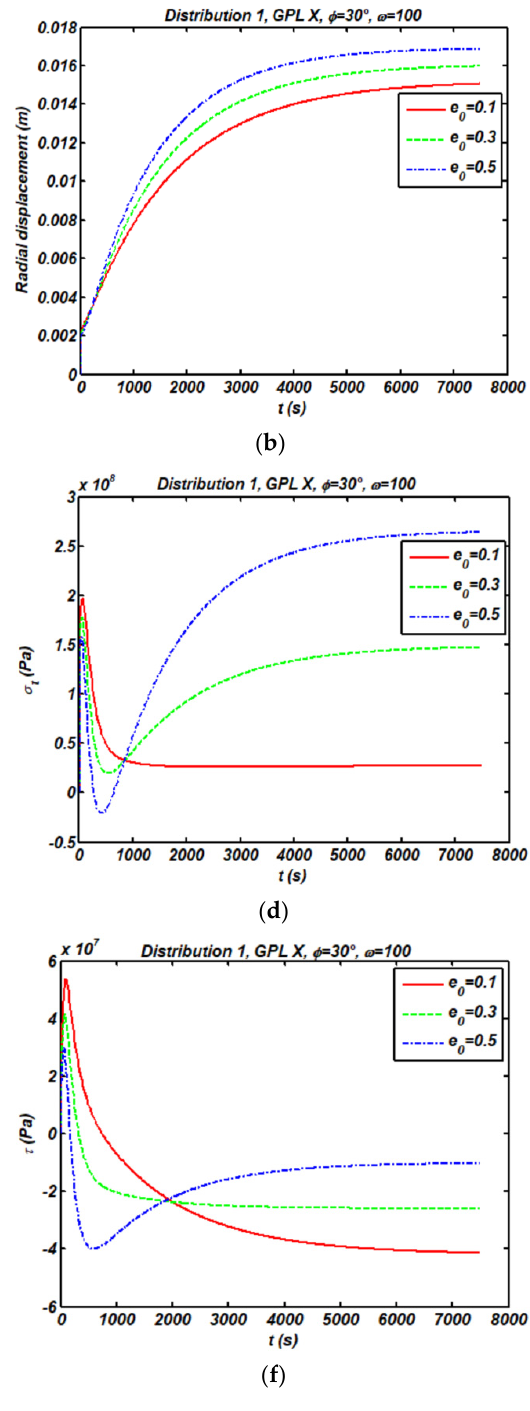
γ ω φ = 30°; GPL = 0.01; =